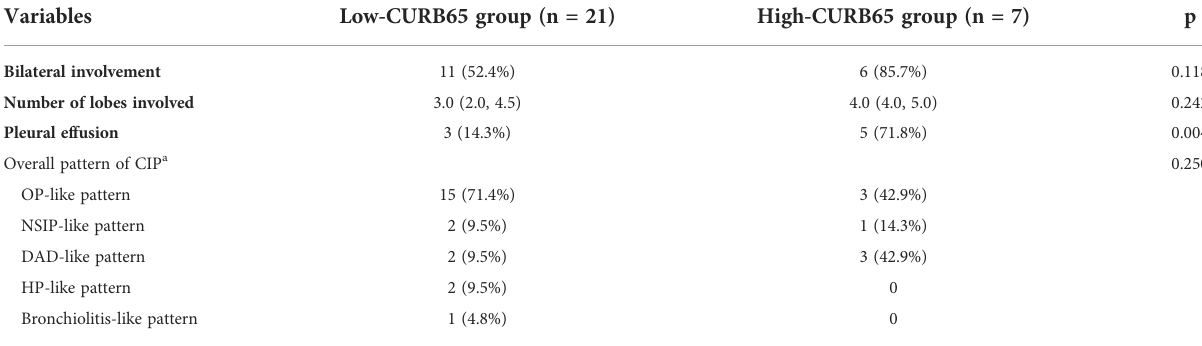
TABLE 4 Radiographic appearances of